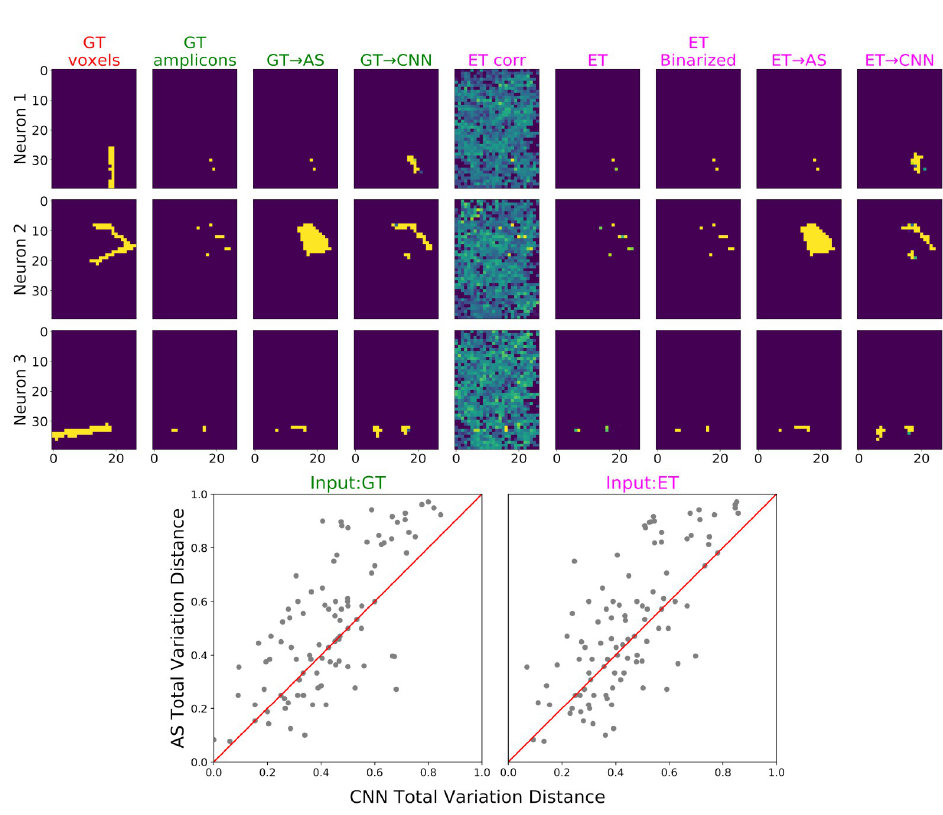
Fig 11. Morphology reconstruction results from CNN on low-resolution, sparse-expression simulations. Similar to Fig 9 for high-resolution simulation, this figure compares morphology reconstructions from low-resolution data using alphashape (AS) and CNN, with ground-truth (GT) amplicons and evidence tensor (ET) as input. Overall, we see that micron-precise morphological reconstructions are possible, even from low-resolution STIBEs. Top : Morphology reconstruction results, using either ground-truth amplicons or the evidence tensor as the input to alphashape or CNN. As in Fig 9 the colors of column titles indicate the input categories; from left to right the columns are: the ground-truth morphology, ground-truth amplicons, alphashape and CNN prediction provided ground-truth amplicons as input, evidence tensors using correlation (‘corr’) methods, evidence tensors using amplicon density (described in S1A.3.1 Appendix; note that this is much more accurate than the simple correlation-based method here), thresholded evidence tensor (using amplicon density thresholded at 0.1, see S1 Fig for details on the choice of this threshold), and alphashape and CNN prediction given evidence tensor as input. For the alphashape input, the evidence tensor obtained from amplicon density was binarized with threshold 0.1. Bottom : Evaluating the morphology reconstruction using total variation distance loss (see S1A.3.2 Appendix). On the left we show performance using ground-truth amplicon locations (GT, left) and on the right we show performance using the evidence tensor (amplicon density) derived from the imagestack (ET, right); conventions as in Fig 9. CNNs outperform alphashape modestly